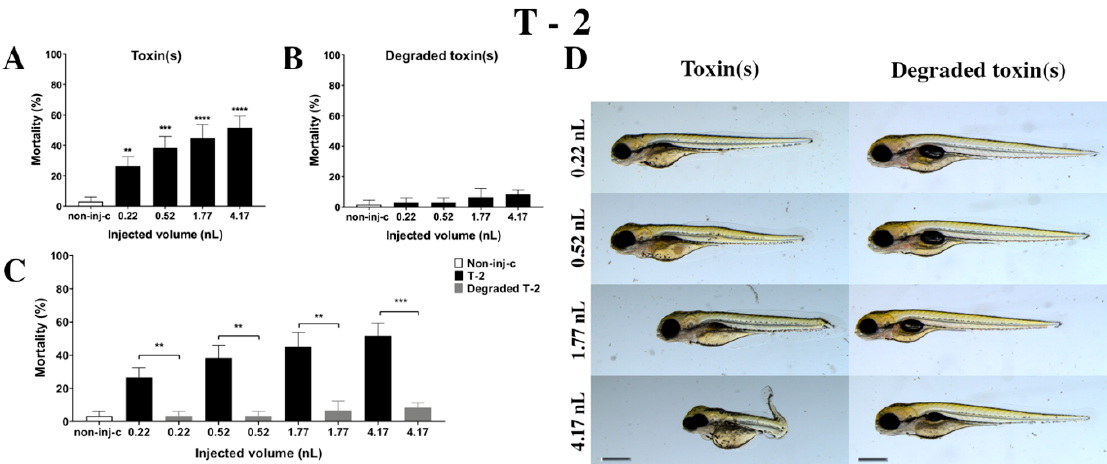
Figure 4. Effects of T-2 ( A ) and its degradation products ( B ) by the Rhodococcus erythropolis NI1 strain on 120 hpf zebrafish embryos. Mortality data are expressed as mean ± SD from three independent experiments in triplicates. Kruskal–Wallis followed by Dunn’s post-hoc test and Mann–Whitney test were used. Mortality values were compared to the non-injected control (non-inj-c) (** p < 0.01, *** p < 0.001, **** p < 0.0001); lethality results of initial T-2 were compared to the degradation products of T-2 ( C ) (** p < 0.01, *** p < 0.001). T-2 and its degradation products induced developmental dysfunctions ( D ) in zebrafish embryos examined at 120 h. Representative phenotypic deformities induced by T-2 were hook-like tail, tail deformities, yolk edema, head and lens distortion, and swim bladders were not developed at either dose; sublethal effects of its degradation products were not observed. Scale bar: 1 mm. Phenotypes of treated groups were compared to the non-injected control (non-inj-c) (Figure 1C). Quantitative data of developmental dysfunctions in zebrafish embryos are in the Supplementary Materials (Supplementary Table S1).